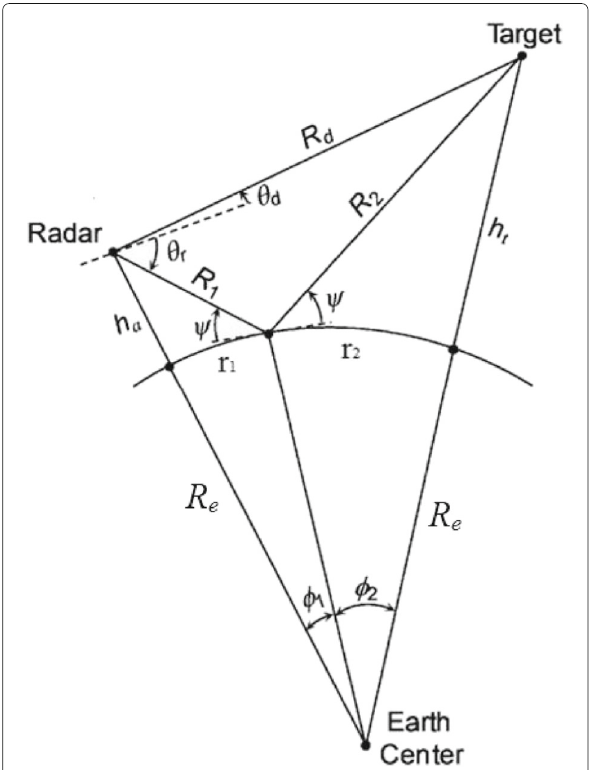
Fig. 1 Spherical-earth model geometry